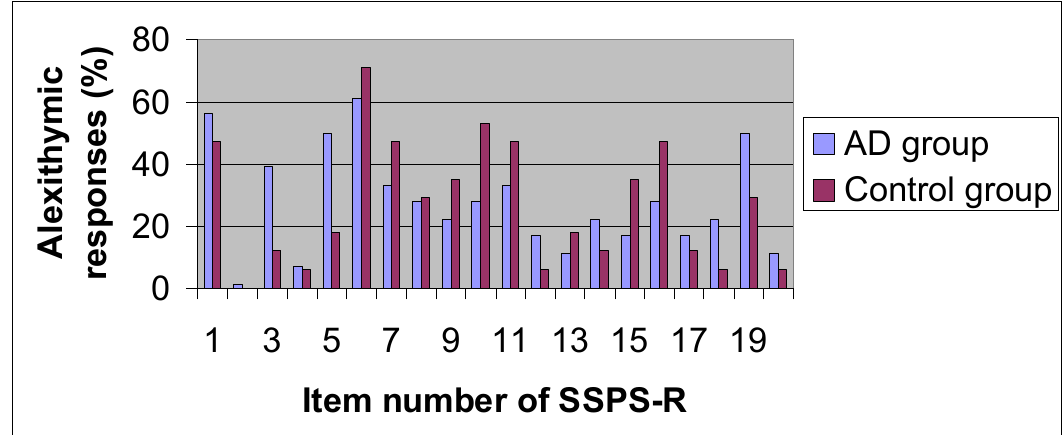
Figure 1. Alexithymic responses (%) of every Shalling Sifneos Psychosomatic Scale (SSPS-R) item in the AD and control groups.